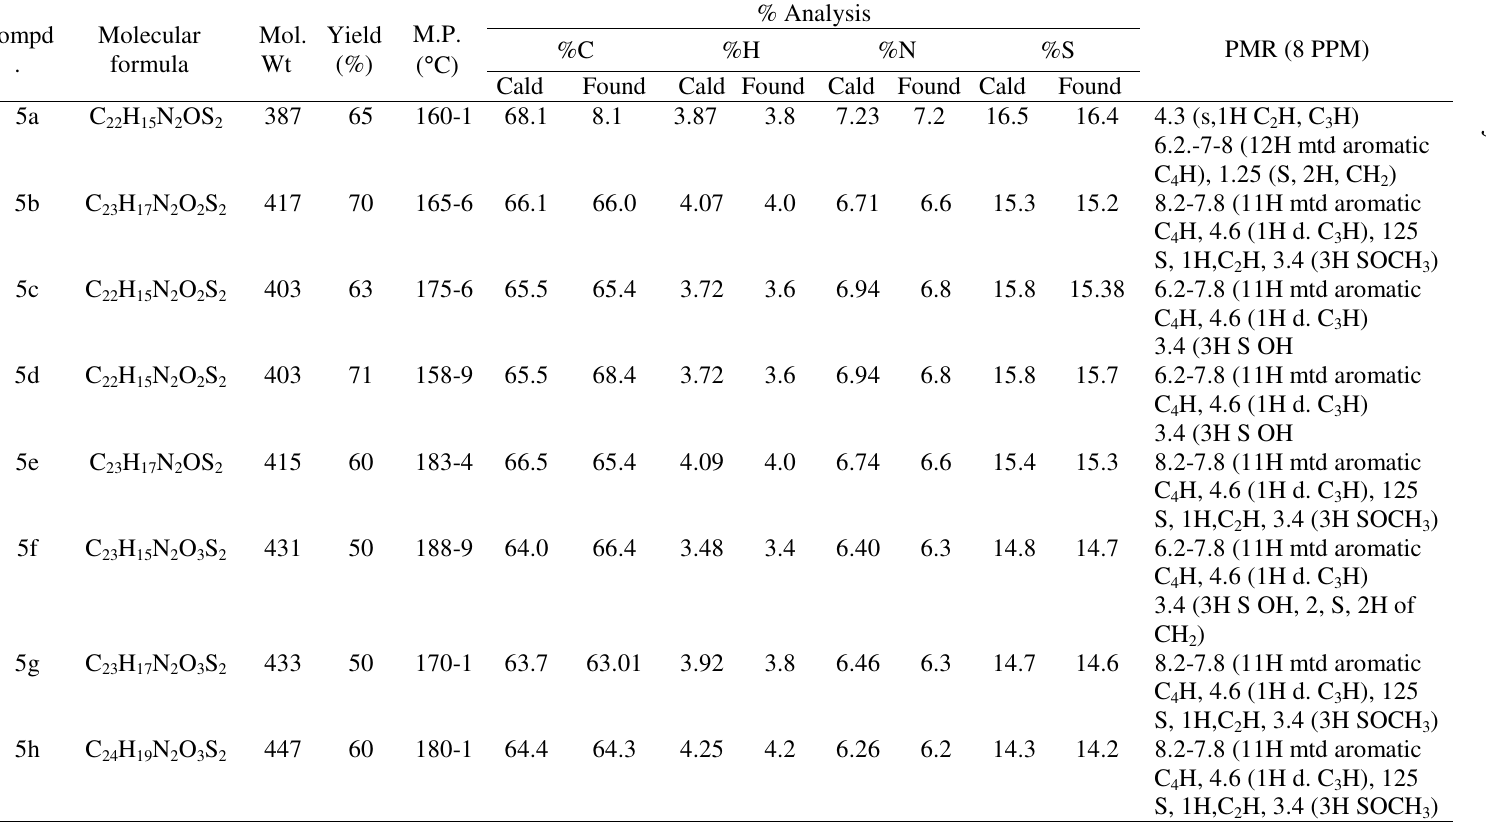
Table 2 Analytical and spectral Data of Commands Thiazolidinones,